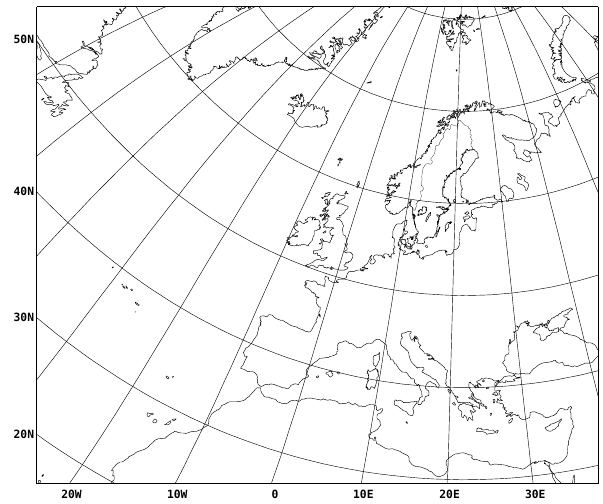
Fig. 2. Model domain for the summer case Hybrid variational en- semble data assimilation experiments.